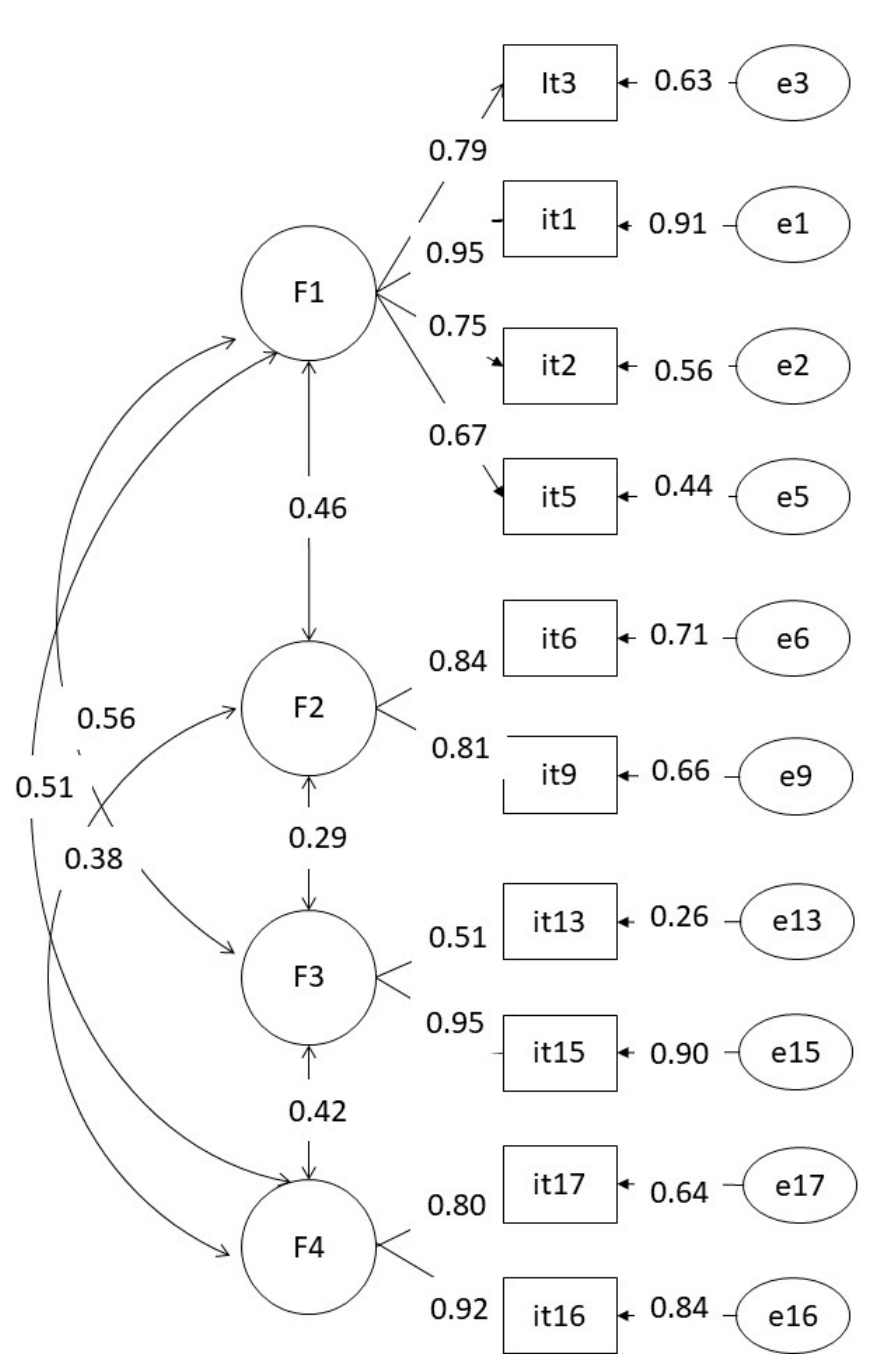
Figure 1. Path diagram and estimates for the four factors model suggested for this instrument.